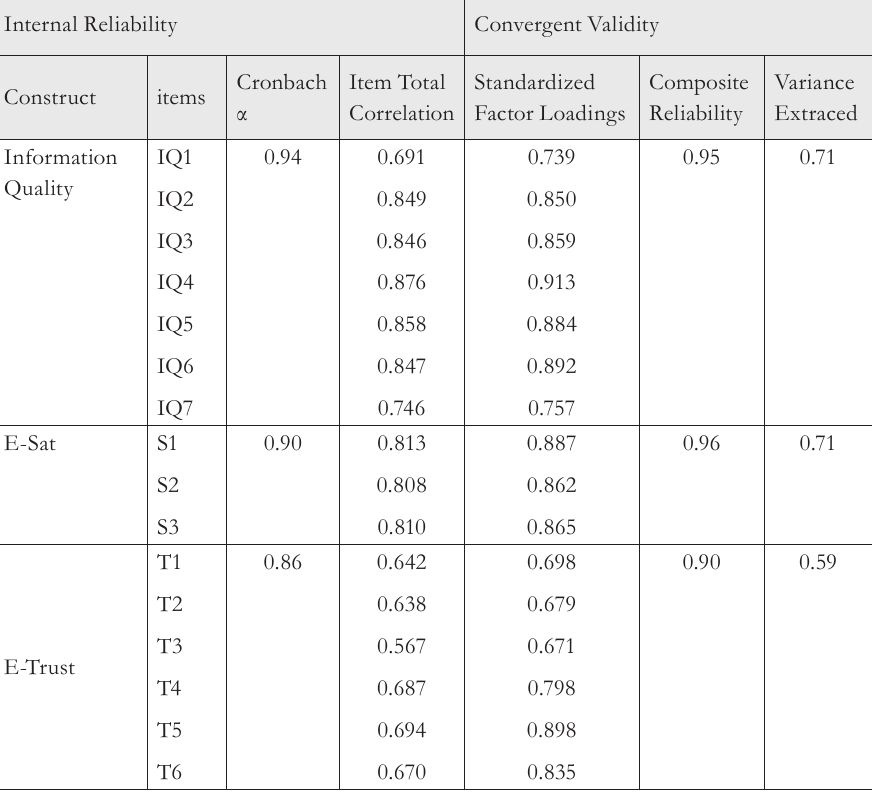
Tab. 3 - Results of internal reliability and convergent validity tests. Source: Authors Own Internal